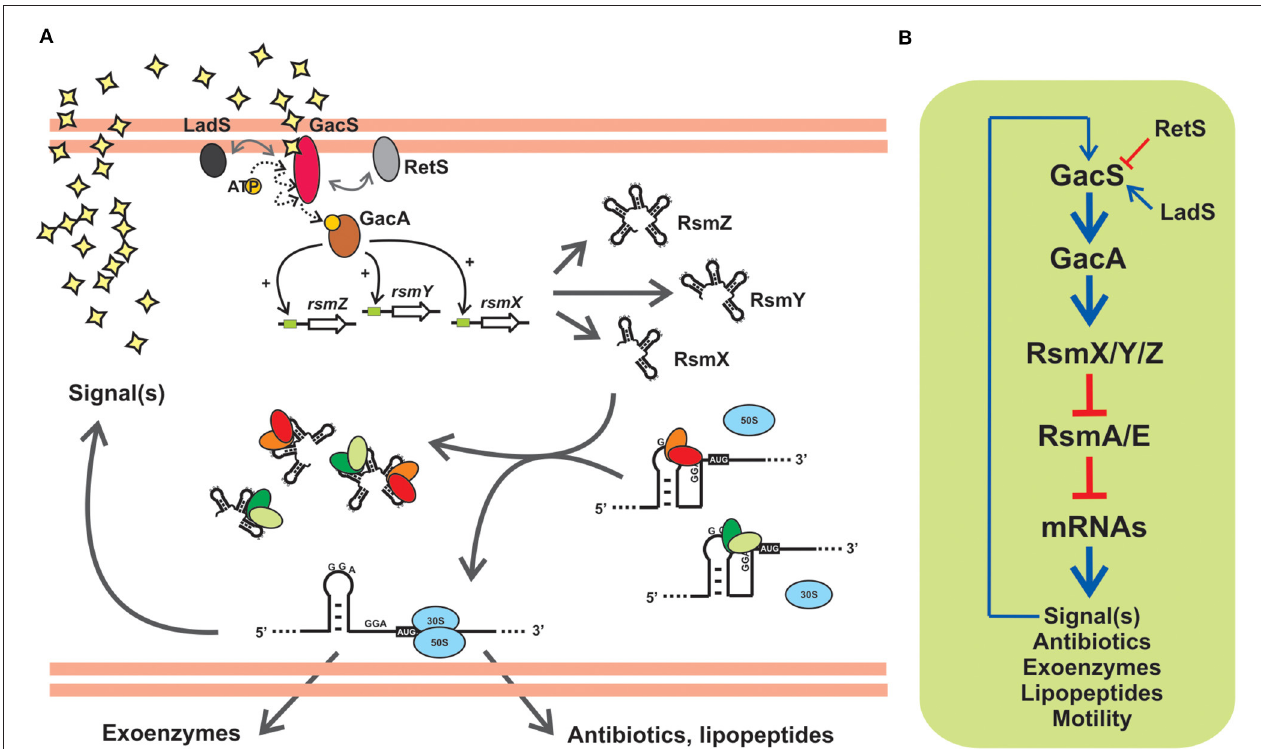
FIGURE 5 | The posttranscriptional Gac-Rsm cascade of Pseudomonas protegens strain CHA0: An archetypal signal transduction pathway of γ -proteobacteria controlling the activity of CsrA proteins with molecular mimic sRNAs. (A) In strain CHA0, the GacS-GacA TCS responds to uncharacterized autoinducing signals, and promotes translation of various mRNAs involved in exoproduct formation and control of plant root pathogens (antibiotics, lipopeptides, extracellular lytic enzymes), by relieving the translational blockage caused by the two CsrA homologs RsmA and RsmE. This is achieved by activating transcription of rsmX , rsmY and rsmZ genes, thereby increasing the intracellular abundance of the three sponge RNAs RsmX, RsmY and RsmZ, that sequester RsmA and RsmE. Two accessory orphan sensor kinases, RetS and LadS, modulate the activity of GacS. (B) Schematic linear representation of the Gac-Rsm regulatory pathway of P. protegens strain CHA0. The biosynthesis of a diffusible signal compound is also under the control of the cascade, as a number of other phenotypes contributing to the antifungal ability of this strain, and it represents a positive feedback input for the pathway. This diagram, as well as the scheme in (A) , is simplified and omits modulatory aspects like the requirement of RsmA/E proteins for a proper expression of rsmX/Y/Z genes ( Valverde et al., 2003; Kay et al., 2005). The number of components in the posttranscriptional module formed by Rsm proteins and Rsm sRNAs, as well as the nature of the target mRNAs, vary between different species (see Tables 1 , 2